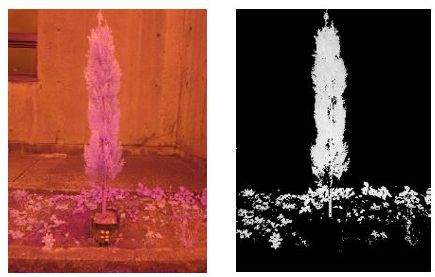
Figure 20. Mask Image after thresholding